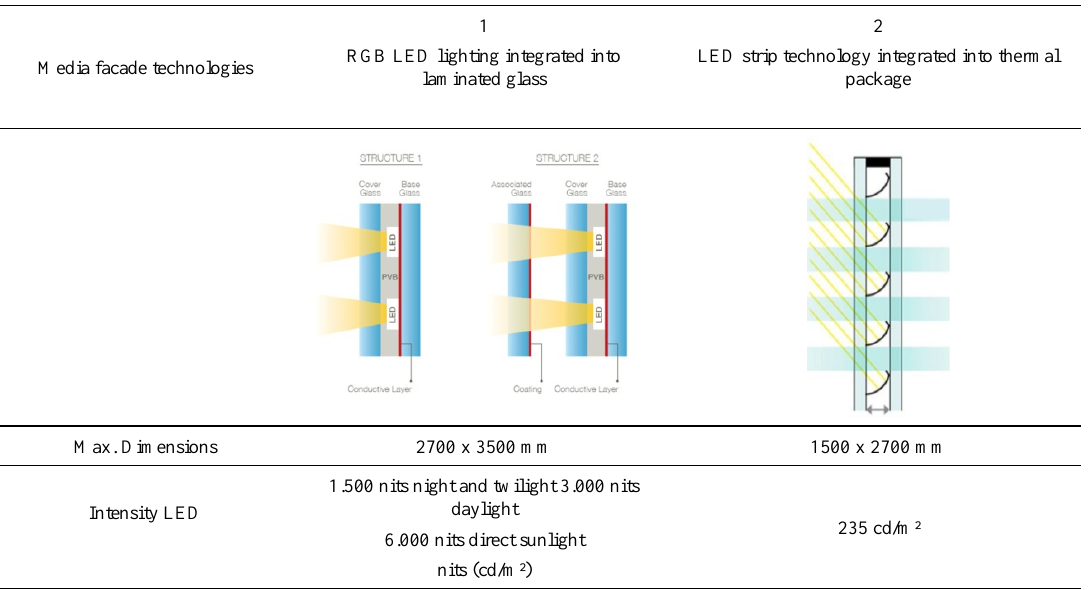
Table 9. Media facade technologies (www.glassiled.com,